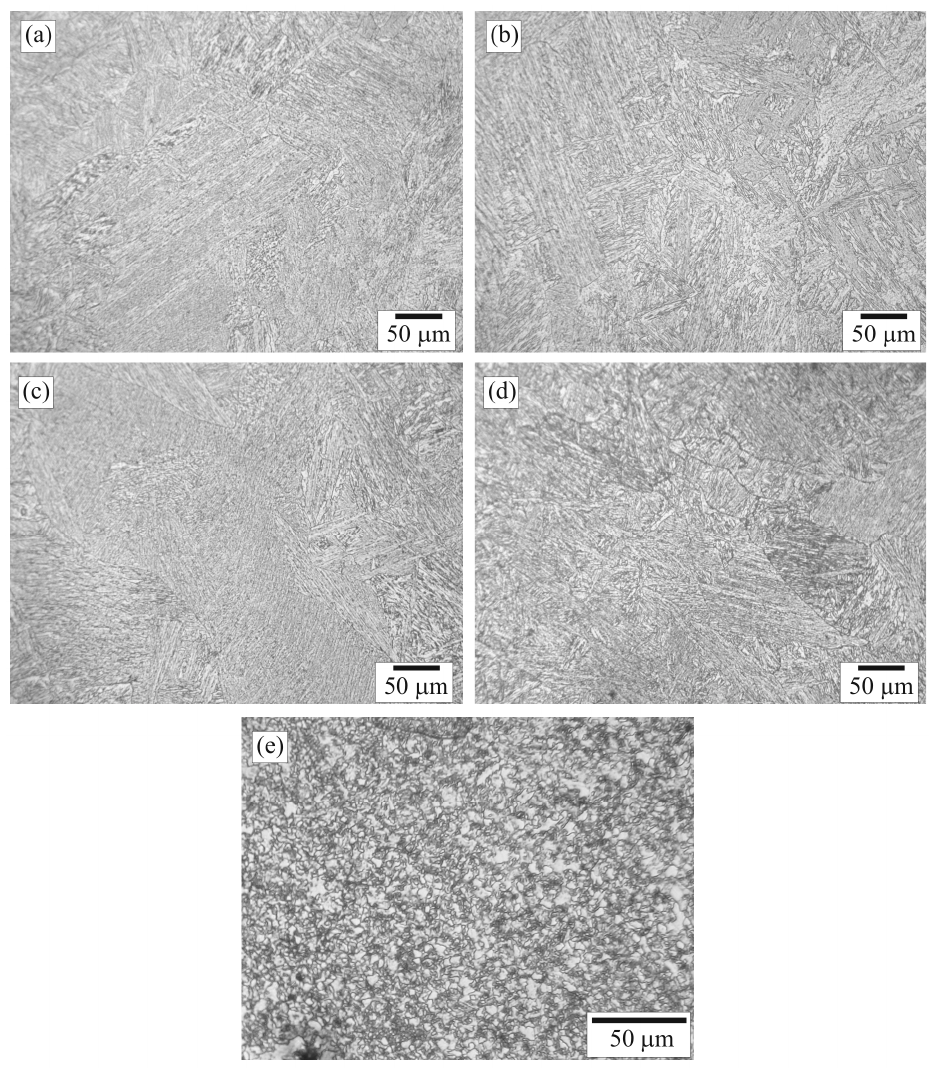
Figure 6. Optical micrographs of positions: ( a ) Ca; ( b ) Cb; ( c ) Cc; ( d ) Cd; and ( e ) Ce in Zone C.